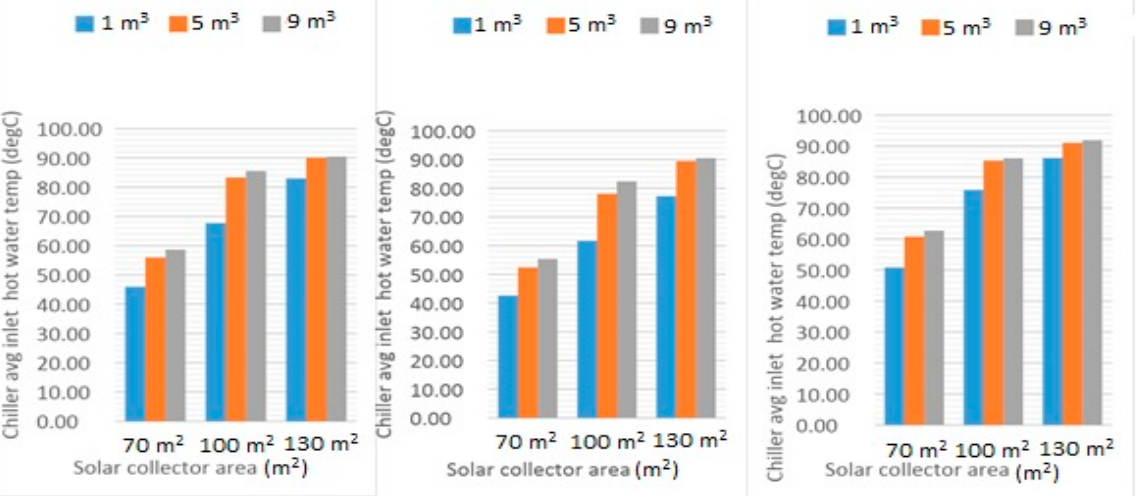
Figure 12. Chiller average inlet hot water temperature at 0.6, 0.8, and 1 kg/s (collector–HW tank– chiller) pumps flow rates.